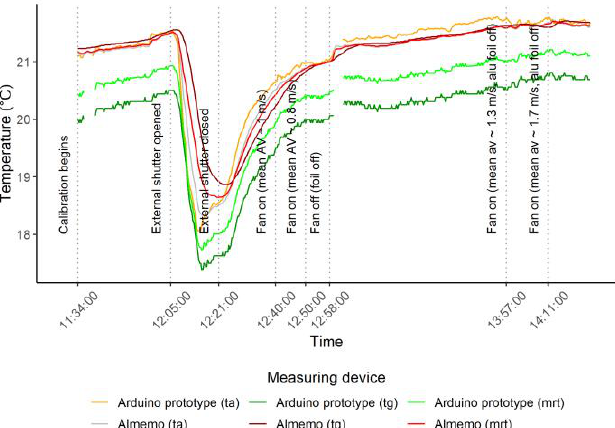
Figure A5. Air (ta), globe (tg) and mean radiant temperature (mrt) recorded by the Arduino prototype and Almemo instrument during various ambient conditions.